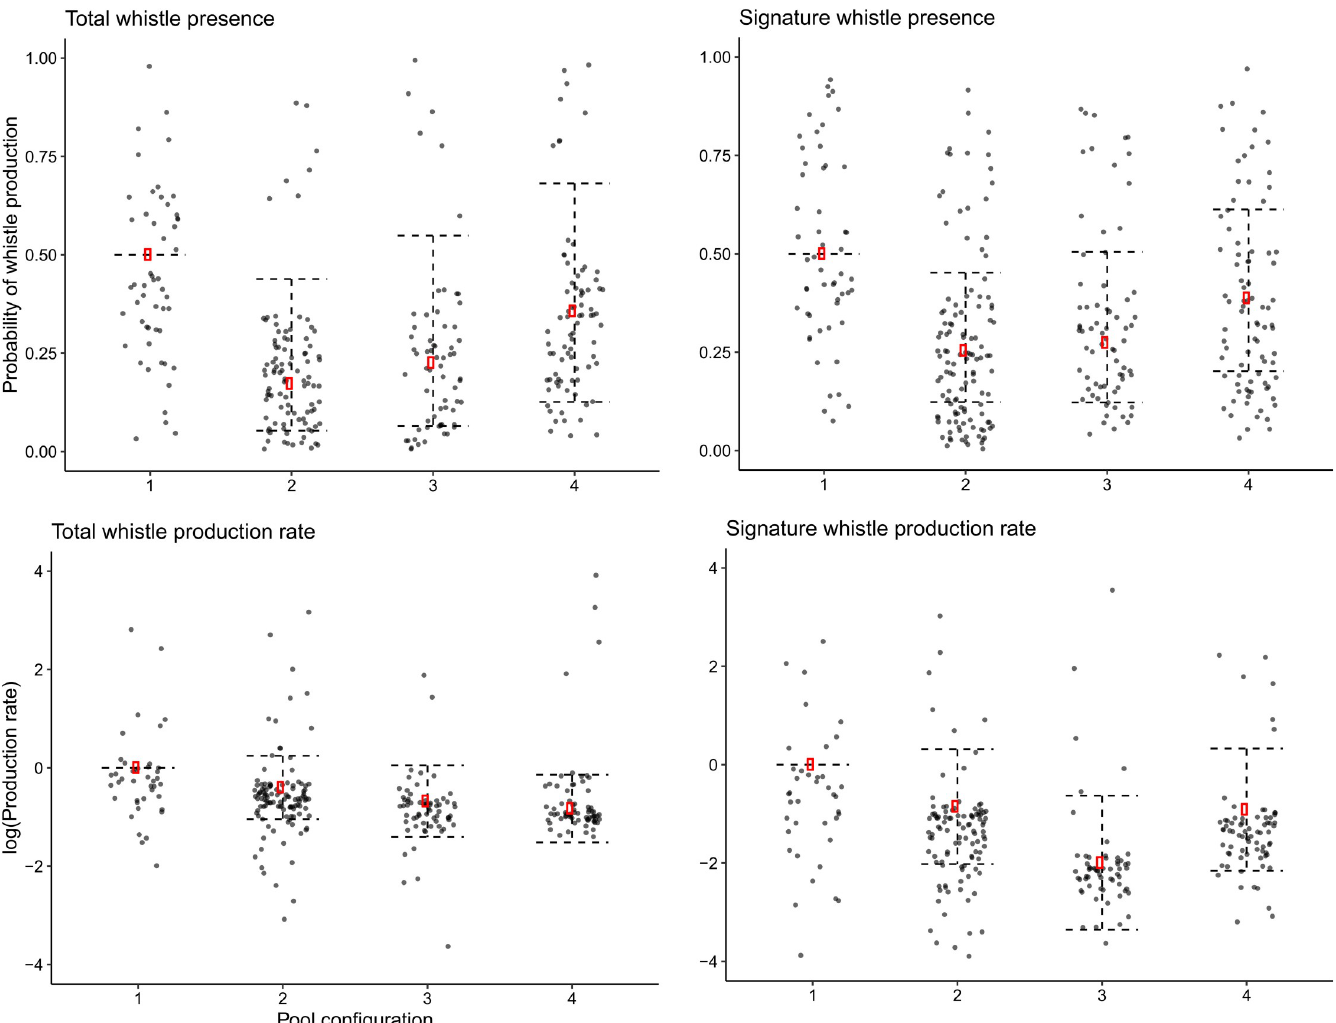
Fig 4. Presence and production rate of whistles and signature whistles compared between pool configurations. This graph shows the GAMM summary of the covariate ‘pool configuration’ for all four models. The y-axis represents the log scale of whistle production rate occurring at each time bin.